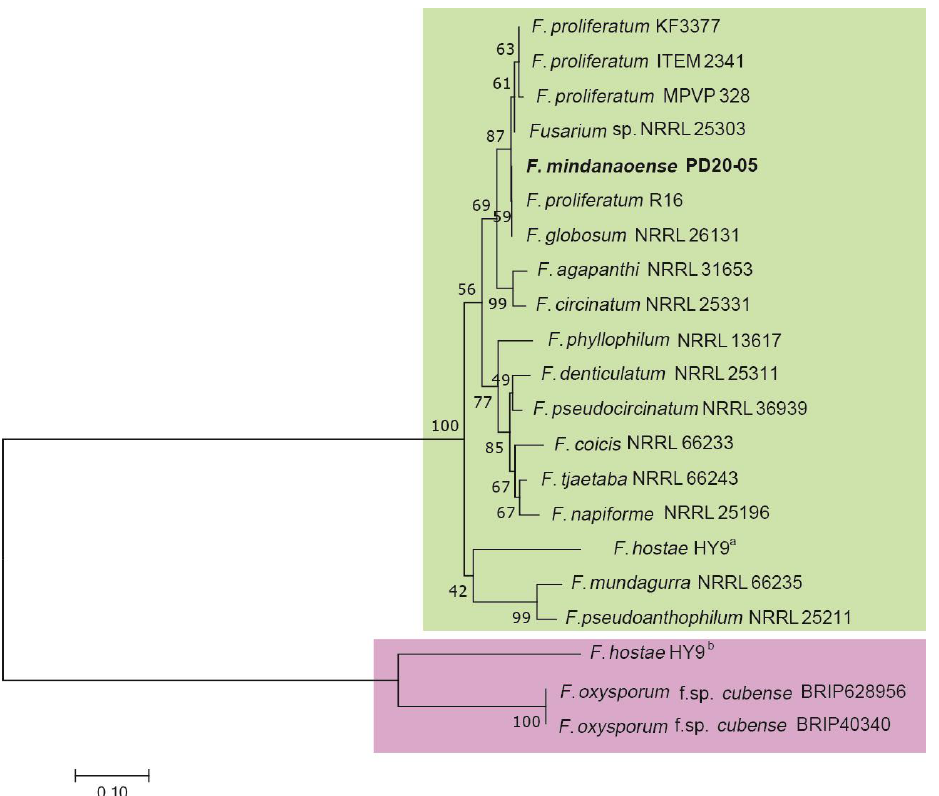
Figure 6. NJ phylogenetic tree based on SIX6 gene sequences. The genes highlighted in red are the SIX6 genes of FFSC, whereas the genes highlighted in green are the SIX6 genes of FOC and F. hostae . F. hostae has two types of SIX6 genes. One belongs to FFSC type ( a ), and another one belongs to FOC type ( b ). type ( b